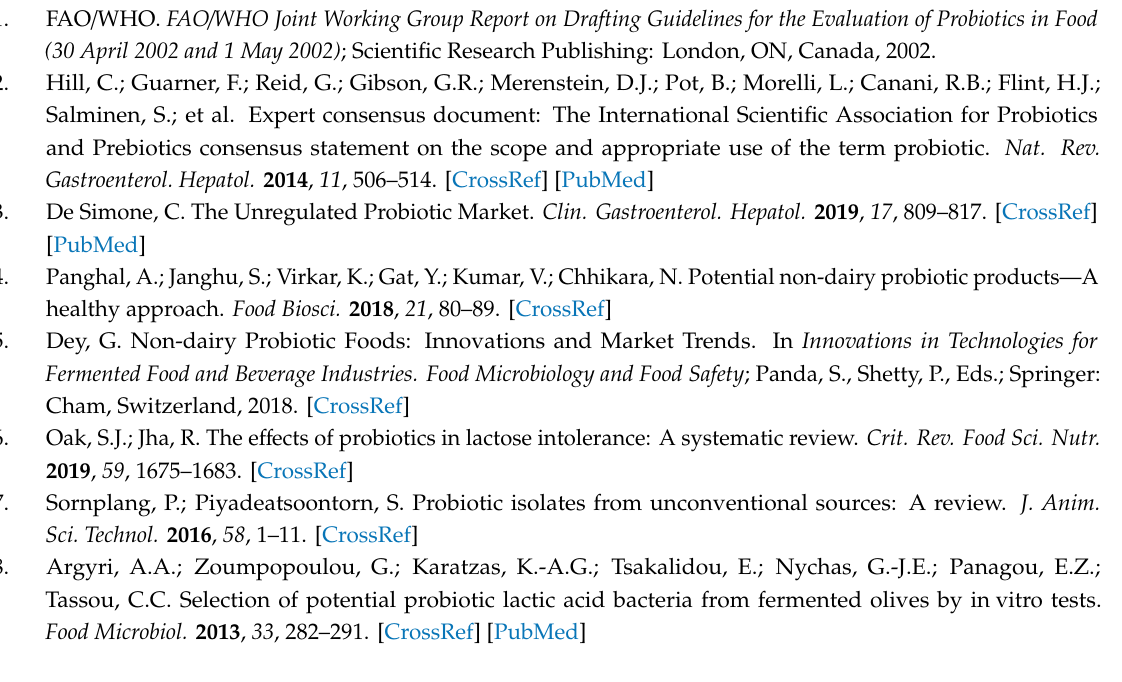
Figure S1: On-plate aspects of the Kombucha LAB inhibitory activity on Candida albicans ATCC 10231 (Ca), Staphylococcus aureus ATCC 33592 methicilin resistant (Sa 33592), Staphylococcus aureus ATCC 25923 methicilin sensitive (Sa 25923), Salmonella typhimurium ATCC 14028 (St) tested by adapted disk di ff usion assay, Figure S2: Aspects of the Kombucha LAB inhibitory activity on Aspergillus carbonarius MI 15 (left) and Penicillium digitatum MI 22 (right) tested by adapted disk di ff usion assay, Figure S3: On-plate test of haemolytic activity of Kombucha LAB isolates on blood agar mediu, Table S1: Results of the molecular identification of Kombucha LAB F1 and F2 by 16S rDNA sequencing with Lac